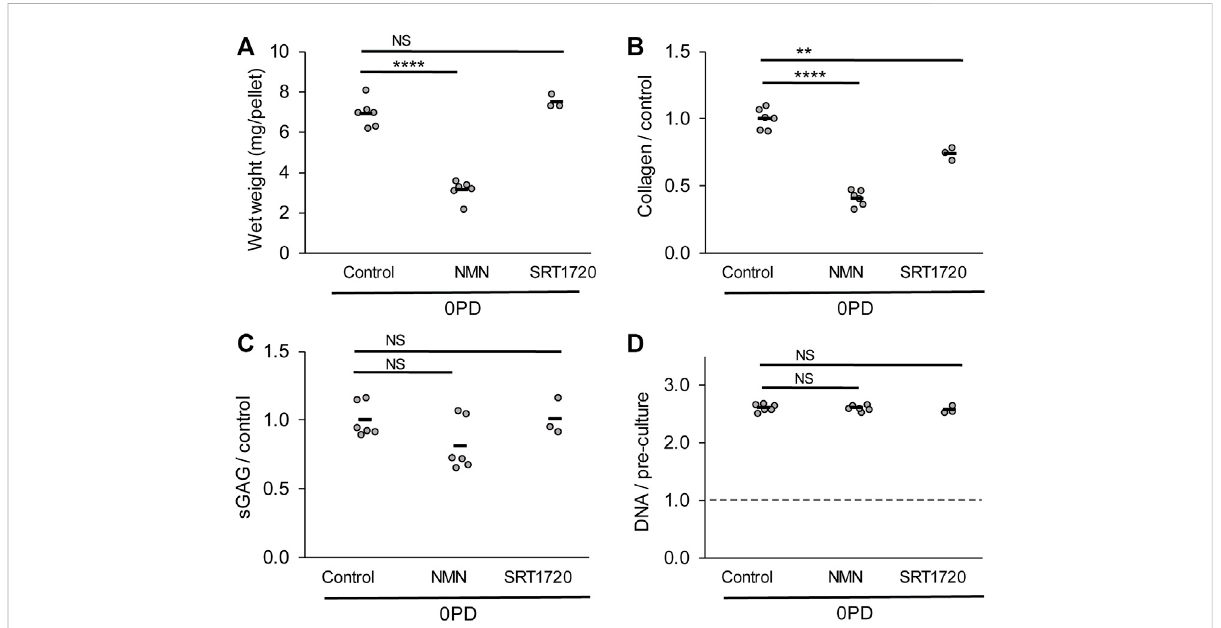
FIGURE 7 Regenerationofcartilagetissuebyfreshlyisolated(0PD)chondrocytesisimpairedbythepresenceofsirtuinactivatorsduring3Dpelletculture. (A) Cellpelletwetweights, (B) collagen, (C) sulphatedglycosaminoglycanand (D) DNAcontentafter21 dayspelletcultureinthepresenceorabsence of sirtuin activators 100 µM NMN or 100 nM SRT1720. DNA content is normalised to pre-culture pellet values at day 0. n = 6 for all groups except SRT1720 where n = 3. The freshly isolated (0 PD) cells were pooled from four donors before pellet formation. Two-way t -test with Bonferroni correction: *** p < 0.001 **** p < 0.0001, NS p >